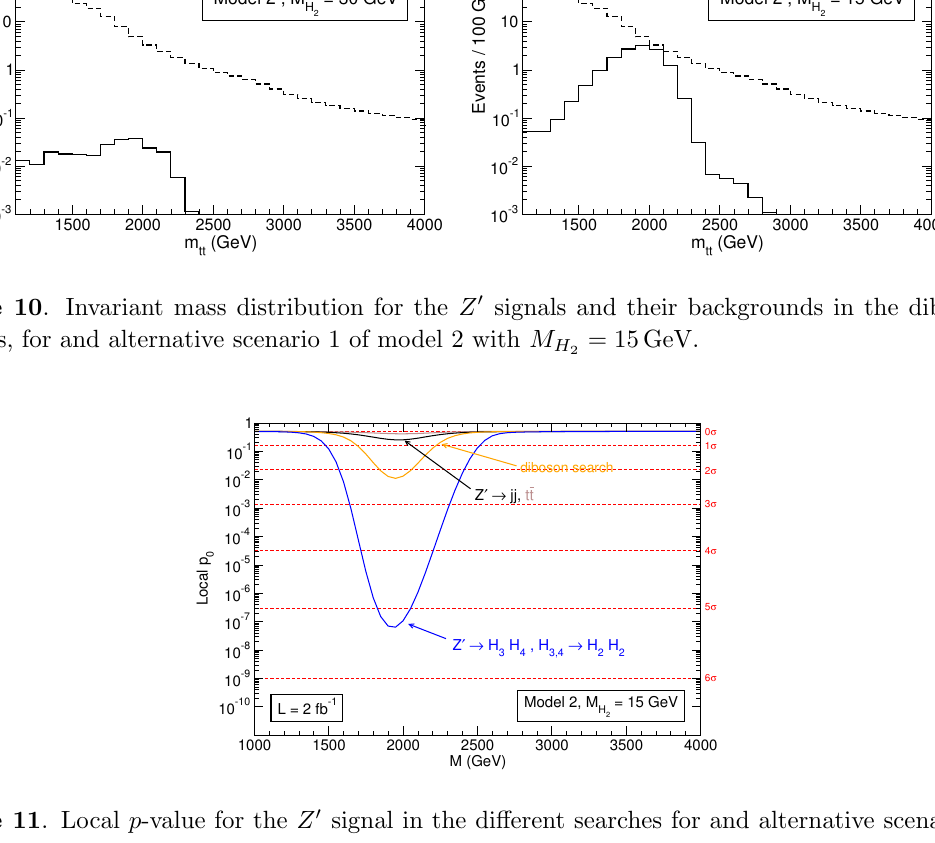
Figure 11 . Local p -value for the Z 0 signal in the di(cid:11)erent searches for and alternative scenario 1 of model 2 with M H = 15 2